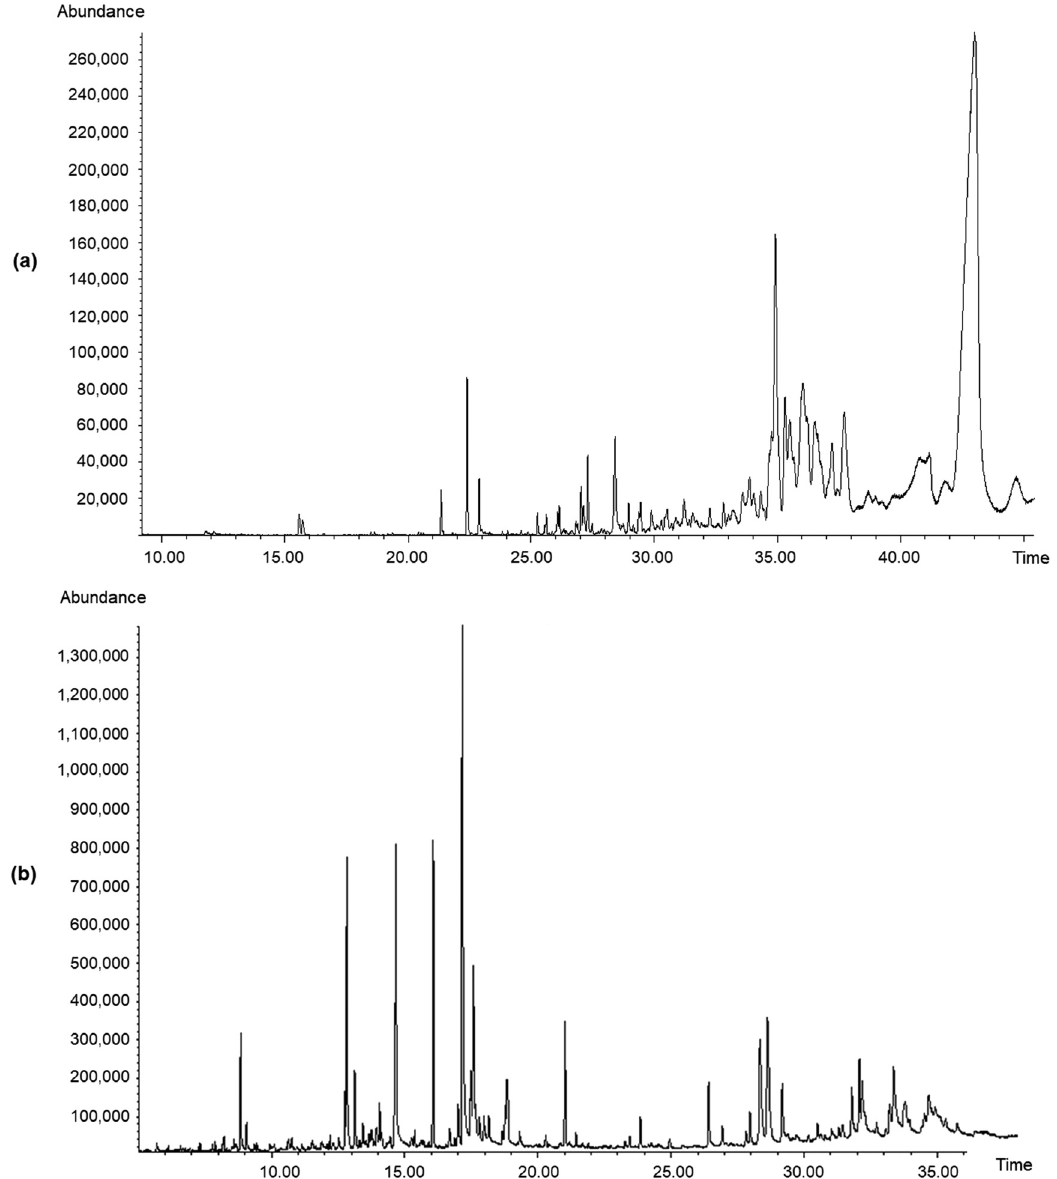
Figure 2: TIC chromatograms ( GC - MS ) of concretes from P. alkekengi leaves: ( a ) phenotype from Central Southern Bulgaria, PA - SB, and ( b ) phenotype from North - Eastern Bulgaria, PA -